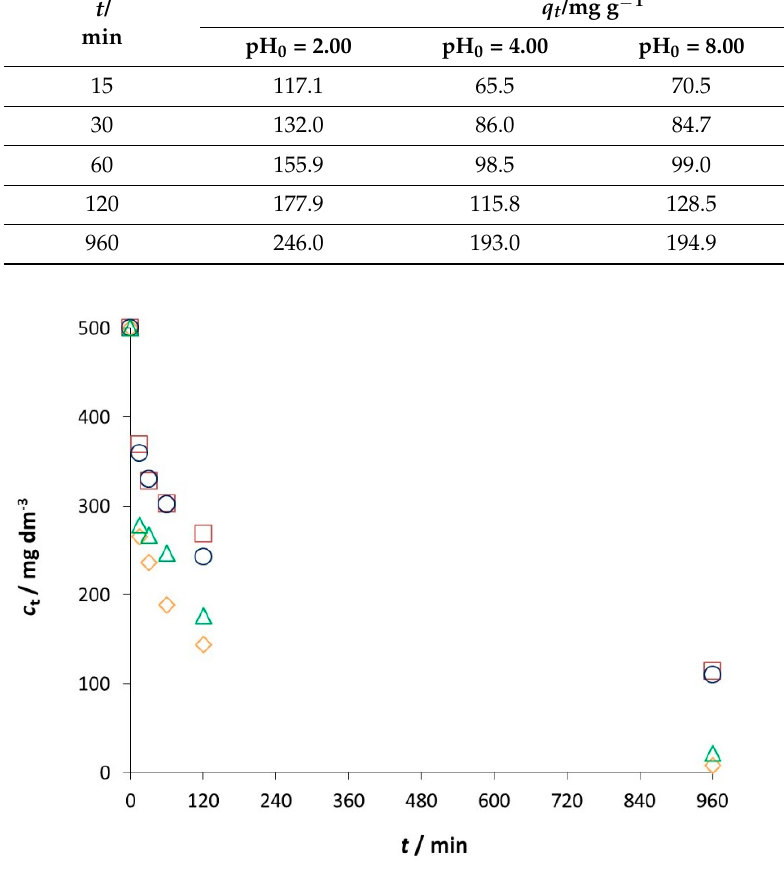
Figure 1. Effect of initial pH values on the RB5 dye concentration in the liquid phase ( c t ) after appropriate time of adsorption ( t ) ( pH 0 = 2.00; pH 0 = 4.00; pH 0 = 8.00; pH 0 = 10.00).